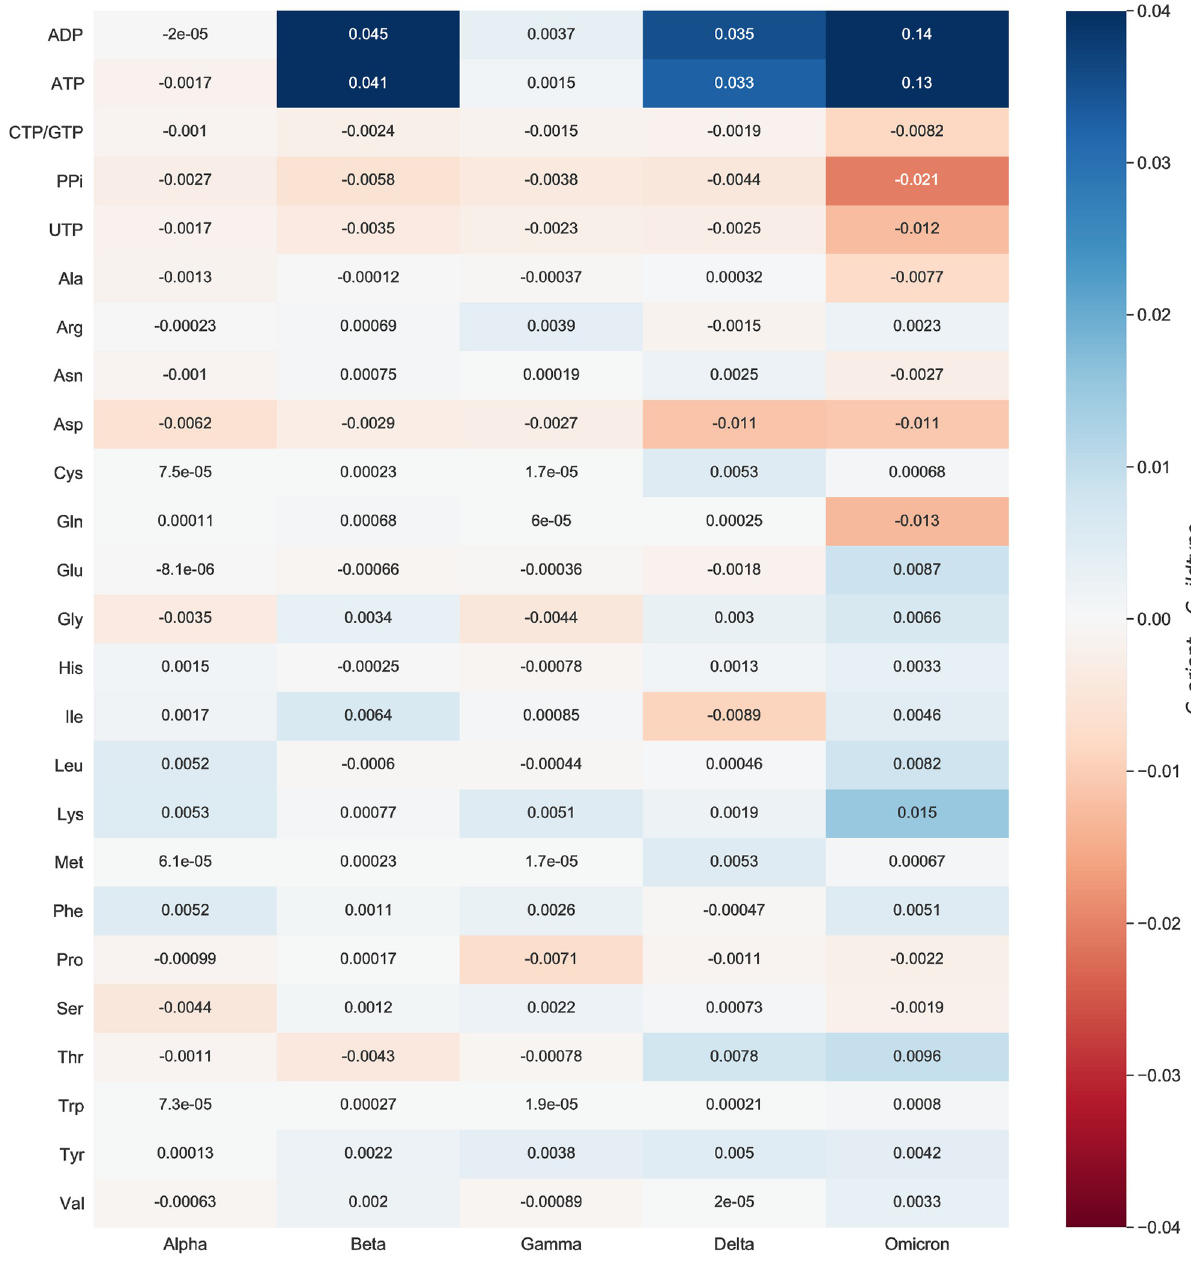
coefficient of ATP [10]. The A TOT is related to the total amino acids counts ( X Alpha variant included more deletions in the spike ( H69del , Y144del , and V70del ) and NSP6 ( F108del , G107del , and S106del ) proteins compared to the Omicron variant. The same holds for the Beta, Gamma, and Delta variants. This affected the X